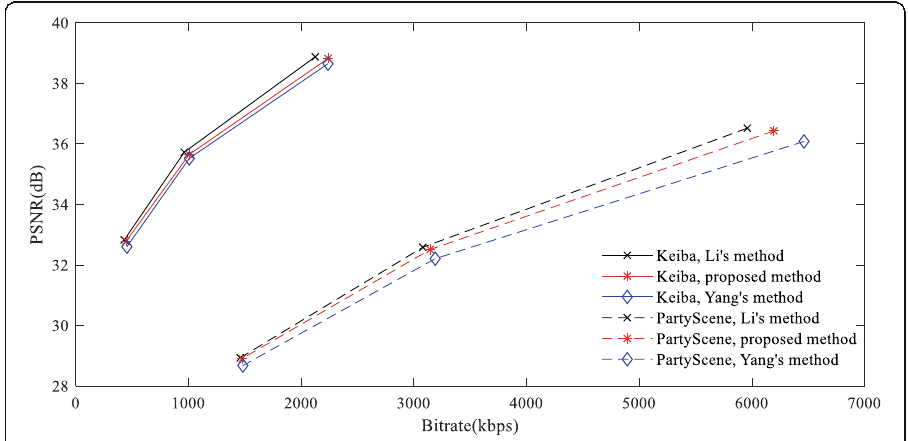
Fig. 10 Comparison of RD with Li ’ s method and Yang ’ s method for sequences Keiba and